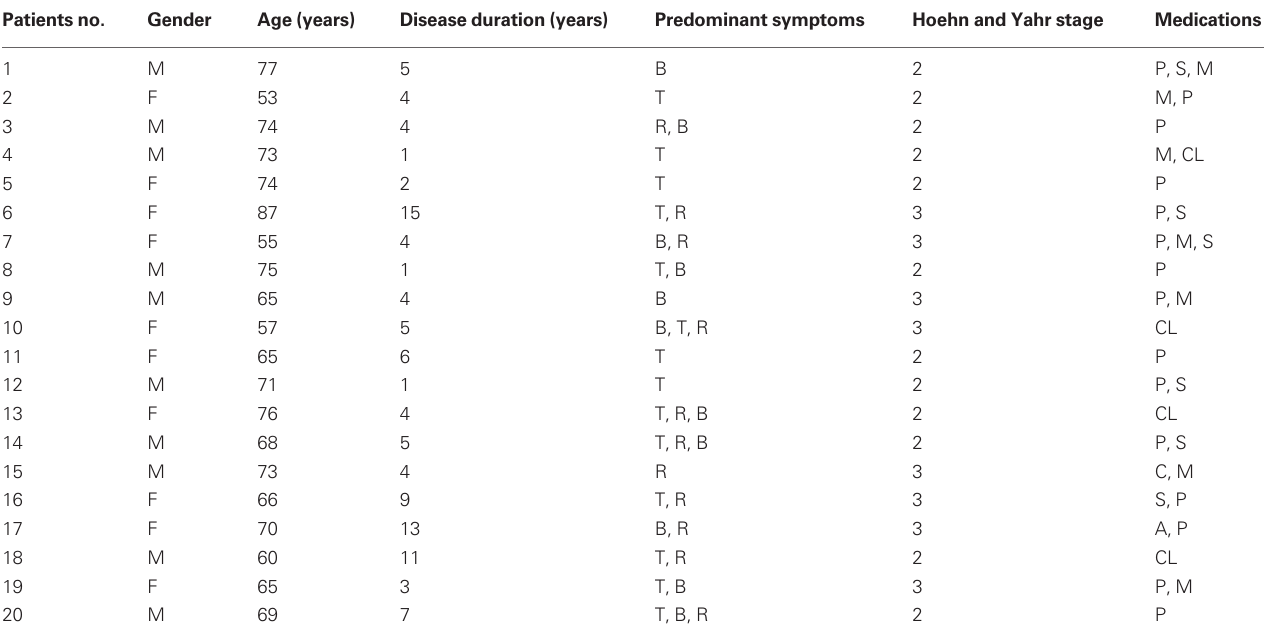
Table 1 | Patients characteristics. Patients